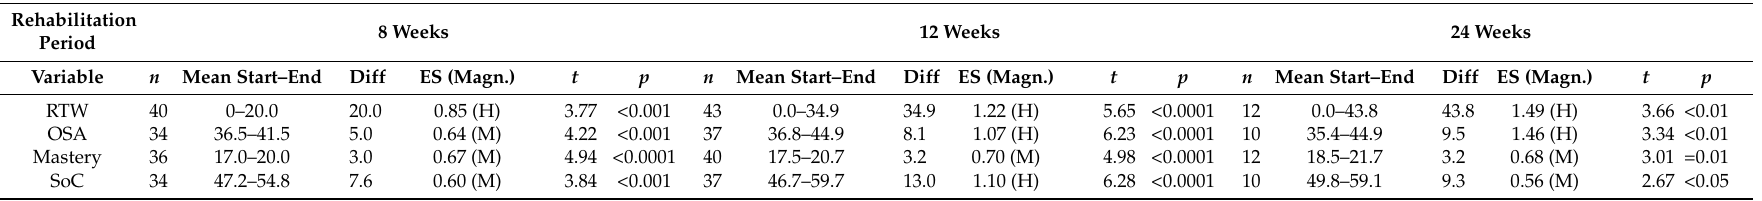
Table 3. Outcome measures for the patients participating in the different rehabilitation periods. Mean values at baseline and follow-up regarding return to work (RTW, %), occupational competence (OSA), personal control (Mastery), and sense of coherence (SoC). Paired t -test, Hedges’ g effect size (ES); with magnitude high (H), medium (M) or small (S) ( n =